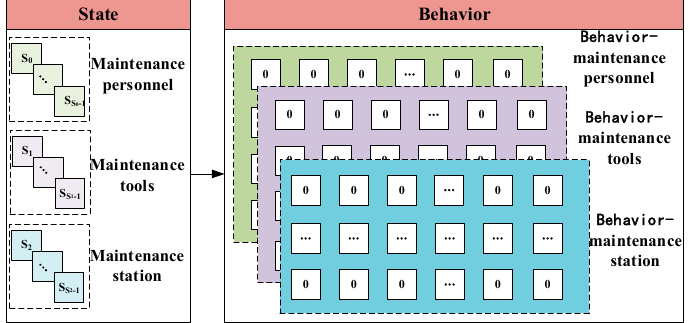
Figure 5. Schematic diagram of state behavior description.